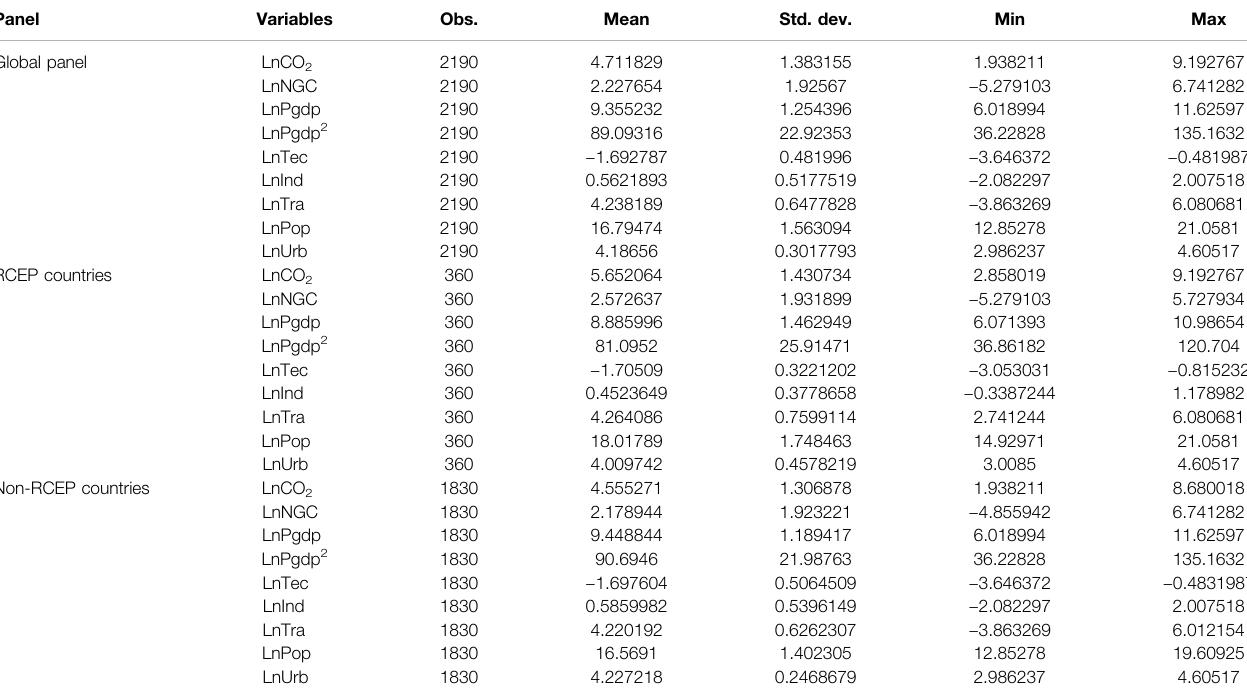
TABLE 2 | Descriptive statistics of all the selected variables (after logarithm). Panel